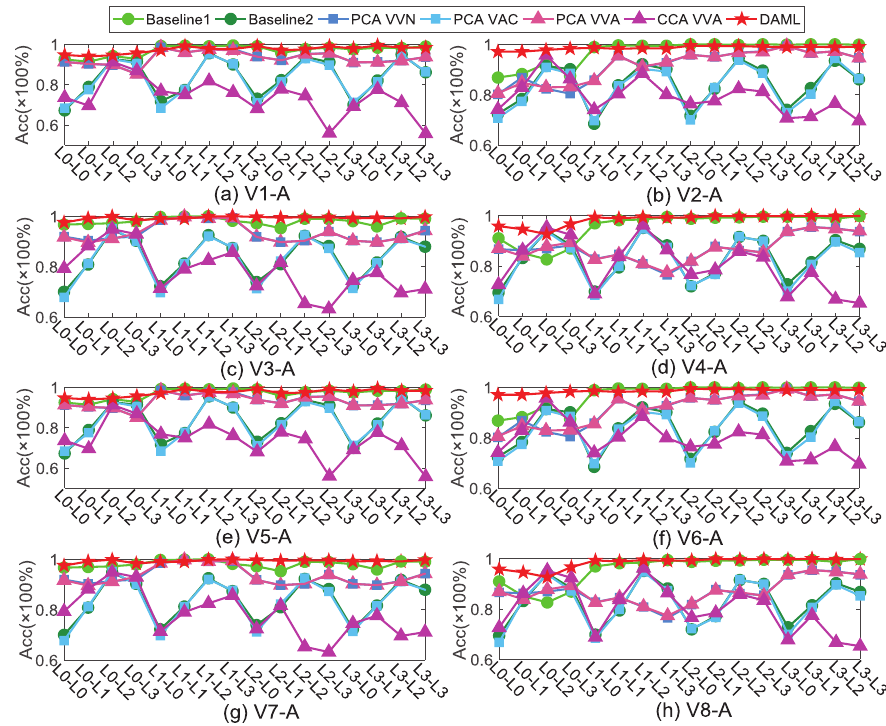
Figure 3. Diagnostic results under the condition of a 10% training sample size, ( a ) V1-A, ( b ) V2-A,